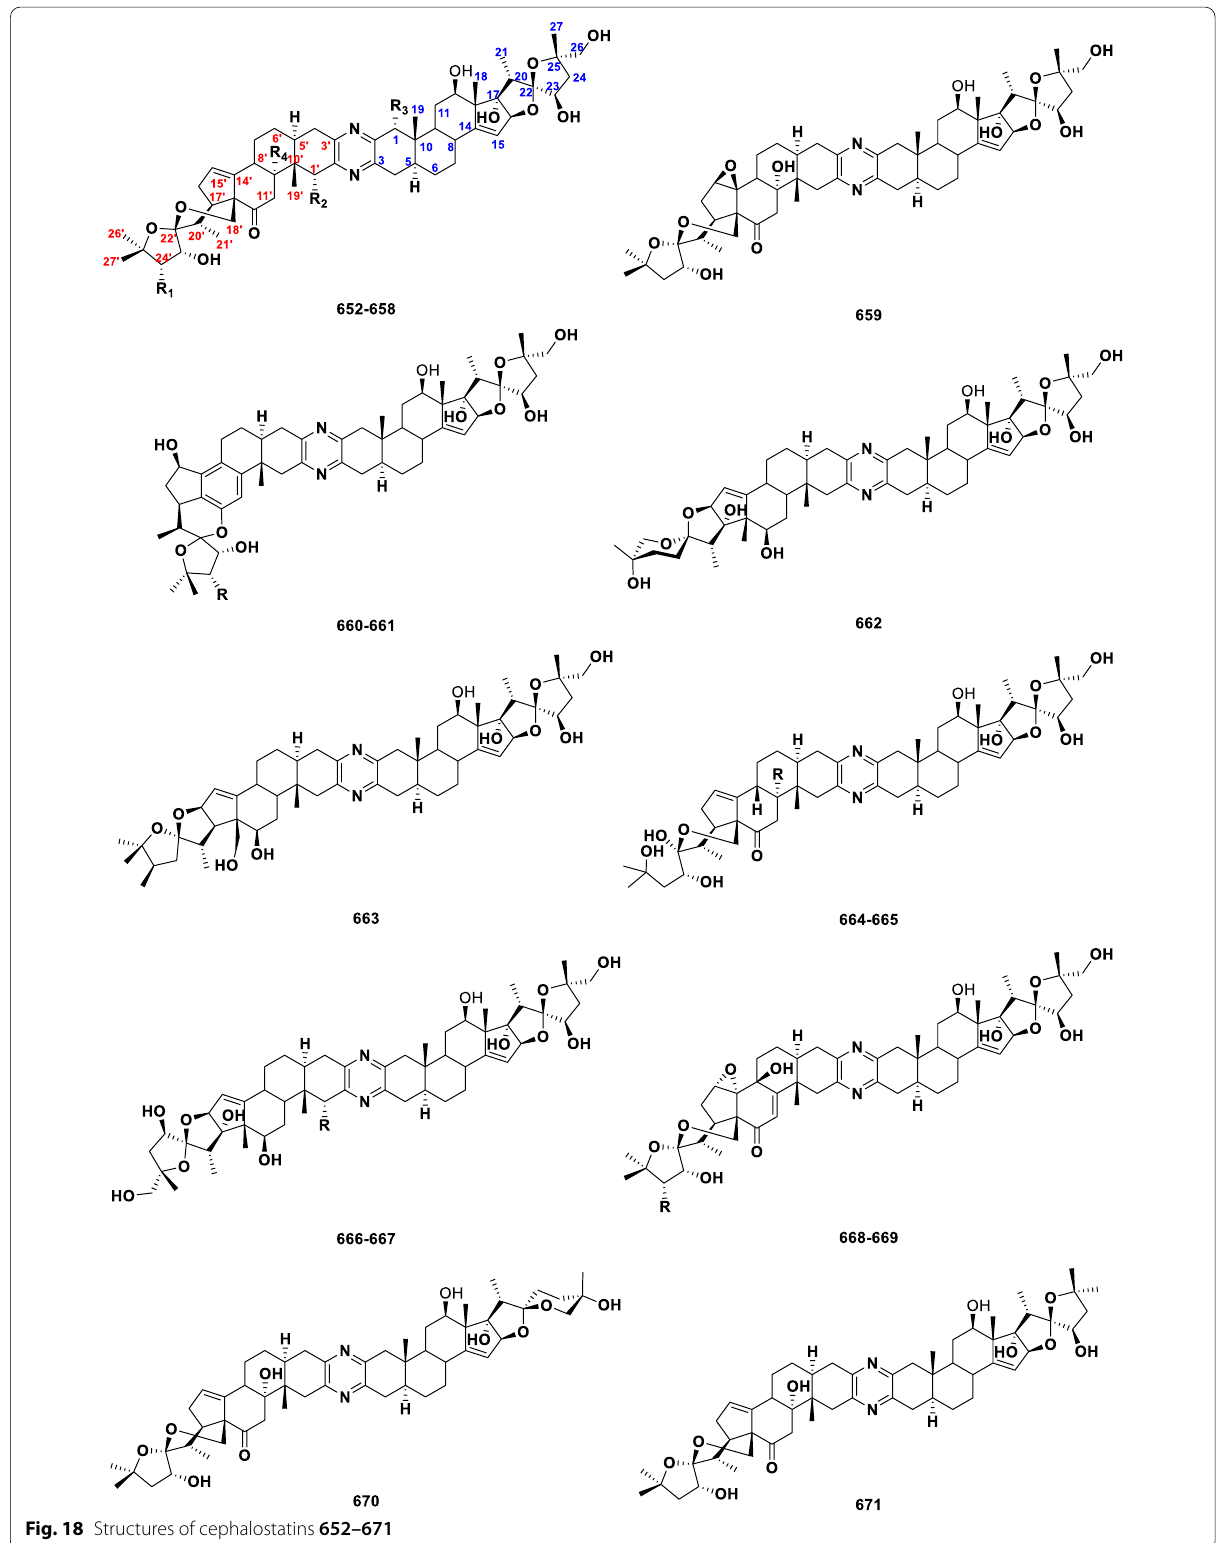
Fig. 18 Structures of cephalostatins